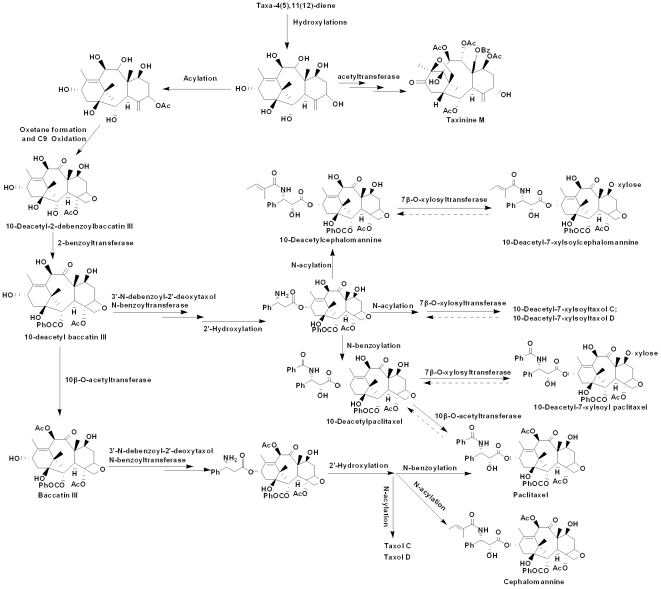
Proposed metabolic framework for taxane biosynthesis in the Taxus root.The committed step of Taxol (paclitaxel) biosynthesis is catalyzed by taxa-4(5),11(12)-diene synthase (TS), a diterpene cyclase responsible for transforming the ubiquitous isoprenoid intermediate geranylgeranyl diphosphate (GGPP) to the parent olefin with a taxane skeleton. Taxadiene is then functionalized by a series of eight CYP-mediated oxygenations, three CoA-dependent acylations, and several other transformations en route to baccatin III, to which the side chain at C13 is appended to afford final product Taxol. Besides Taxol, Taxus species produce about 400 different taxoids, all of which are based upon the unique taxane skeleton. Xylosyltransferases (XYLTs) catalyze the addition of xylosyl group to 10-deacetylpaclitaxel (10-DAT), 10-deacetylcephalomannine (10-DAC), and other 10-deacetyl taxoids transformed from 10-deacetyl baccatin III (10-DAB). These taxoid metabolites may represent defense compounds, and they also constitute significant side-routes that divert pathway flux away from Taxol to decrease production yields of the target drug.